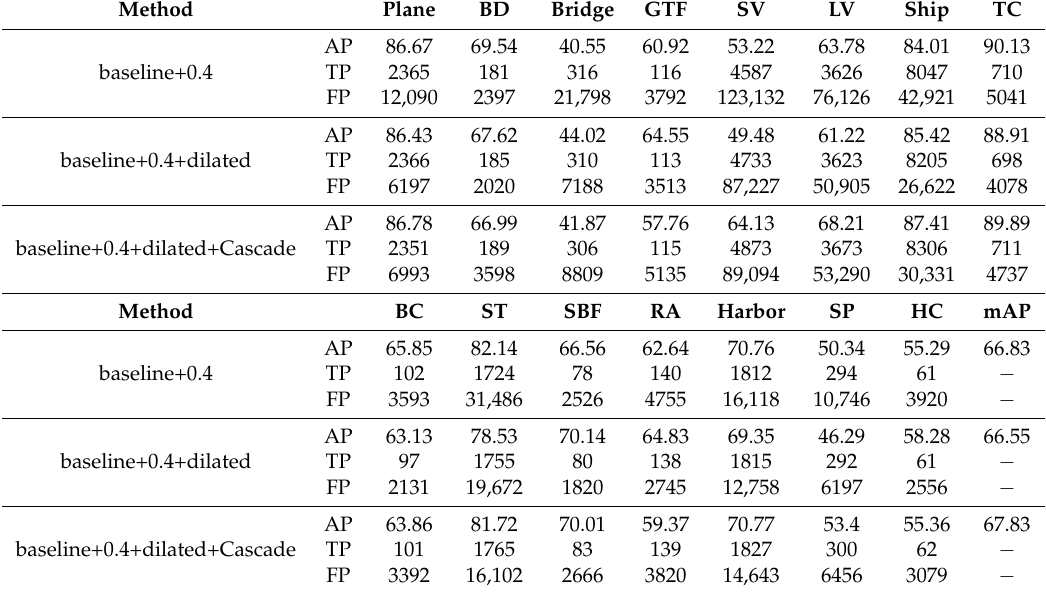
Table 5. The impact of Cascade R-CNN architecture, we evaluate on val set.